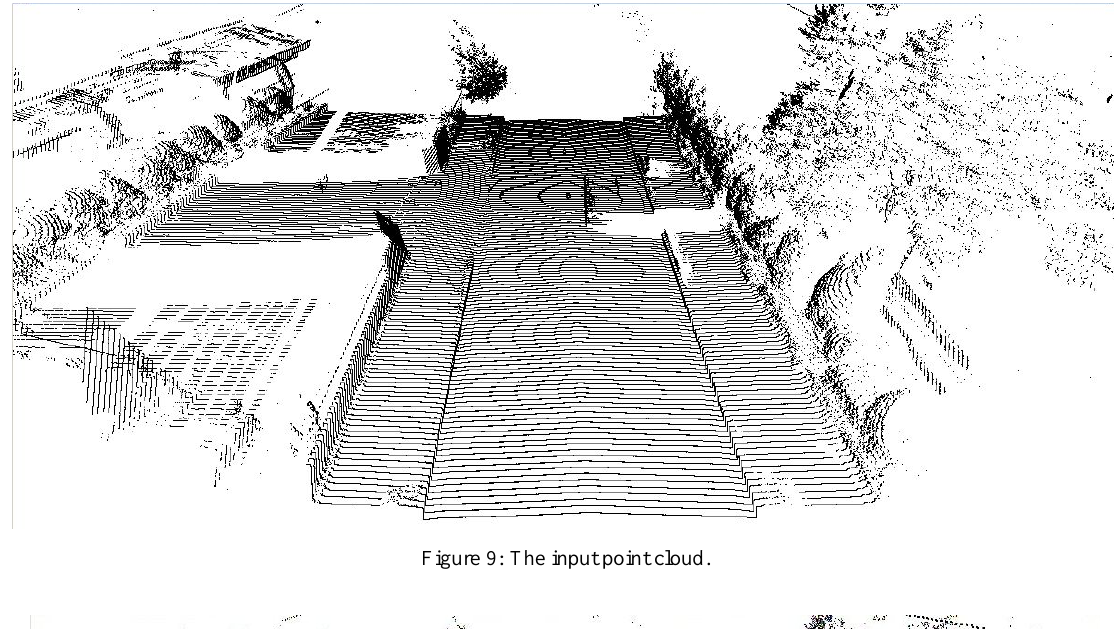
Figure 9: The input point cloud.